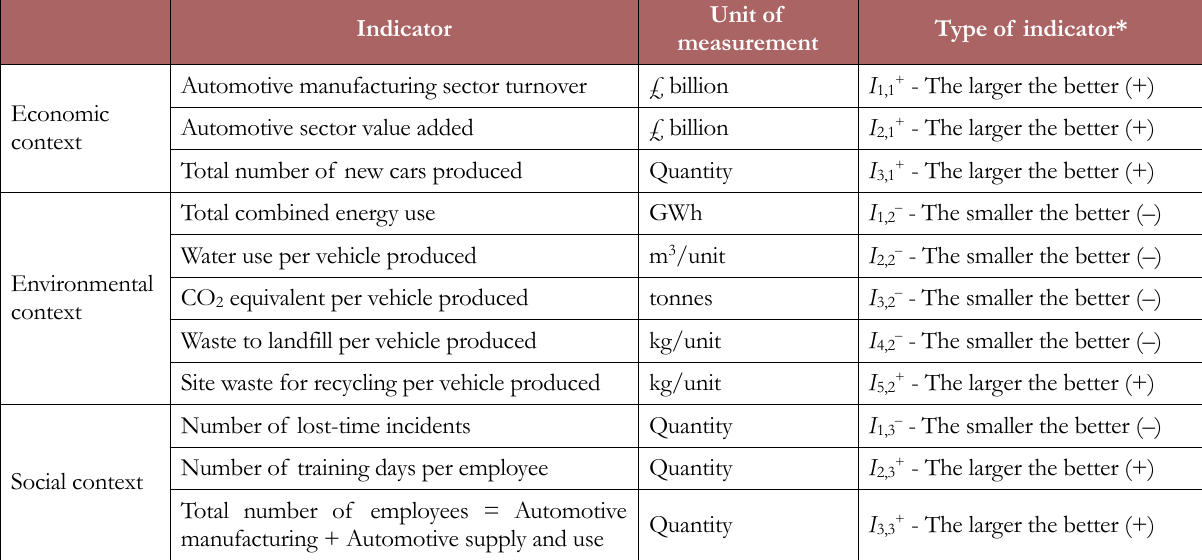
Table 2. Sustainability